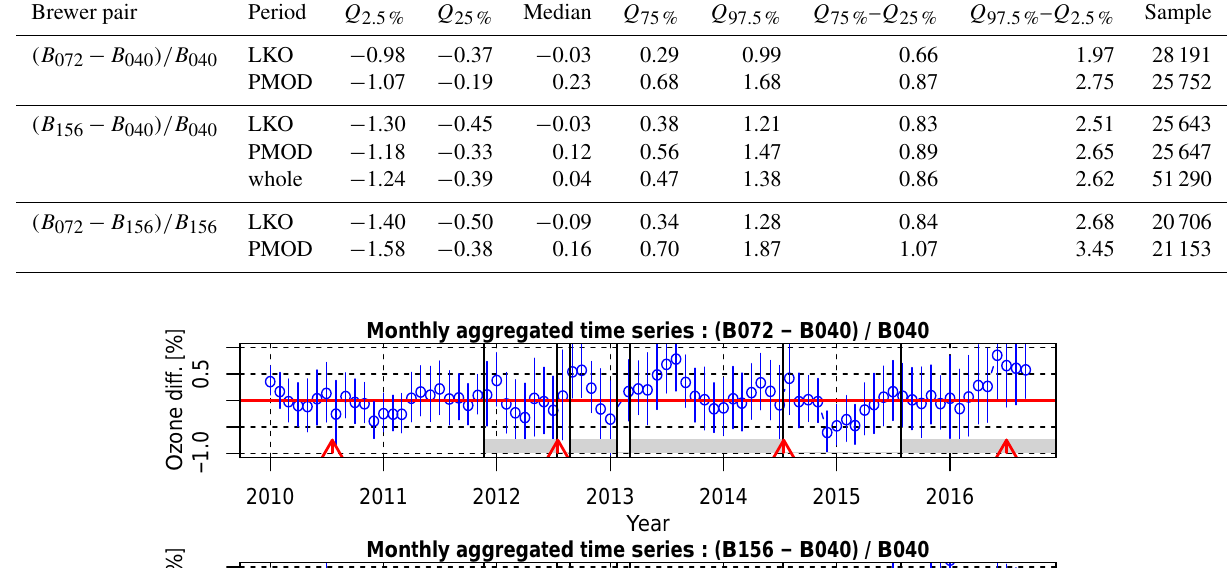
function to fit each instrument separately. The SD σ B a measure of the dispersion of the data around the smoothed daily variation represented by the polynomial function.